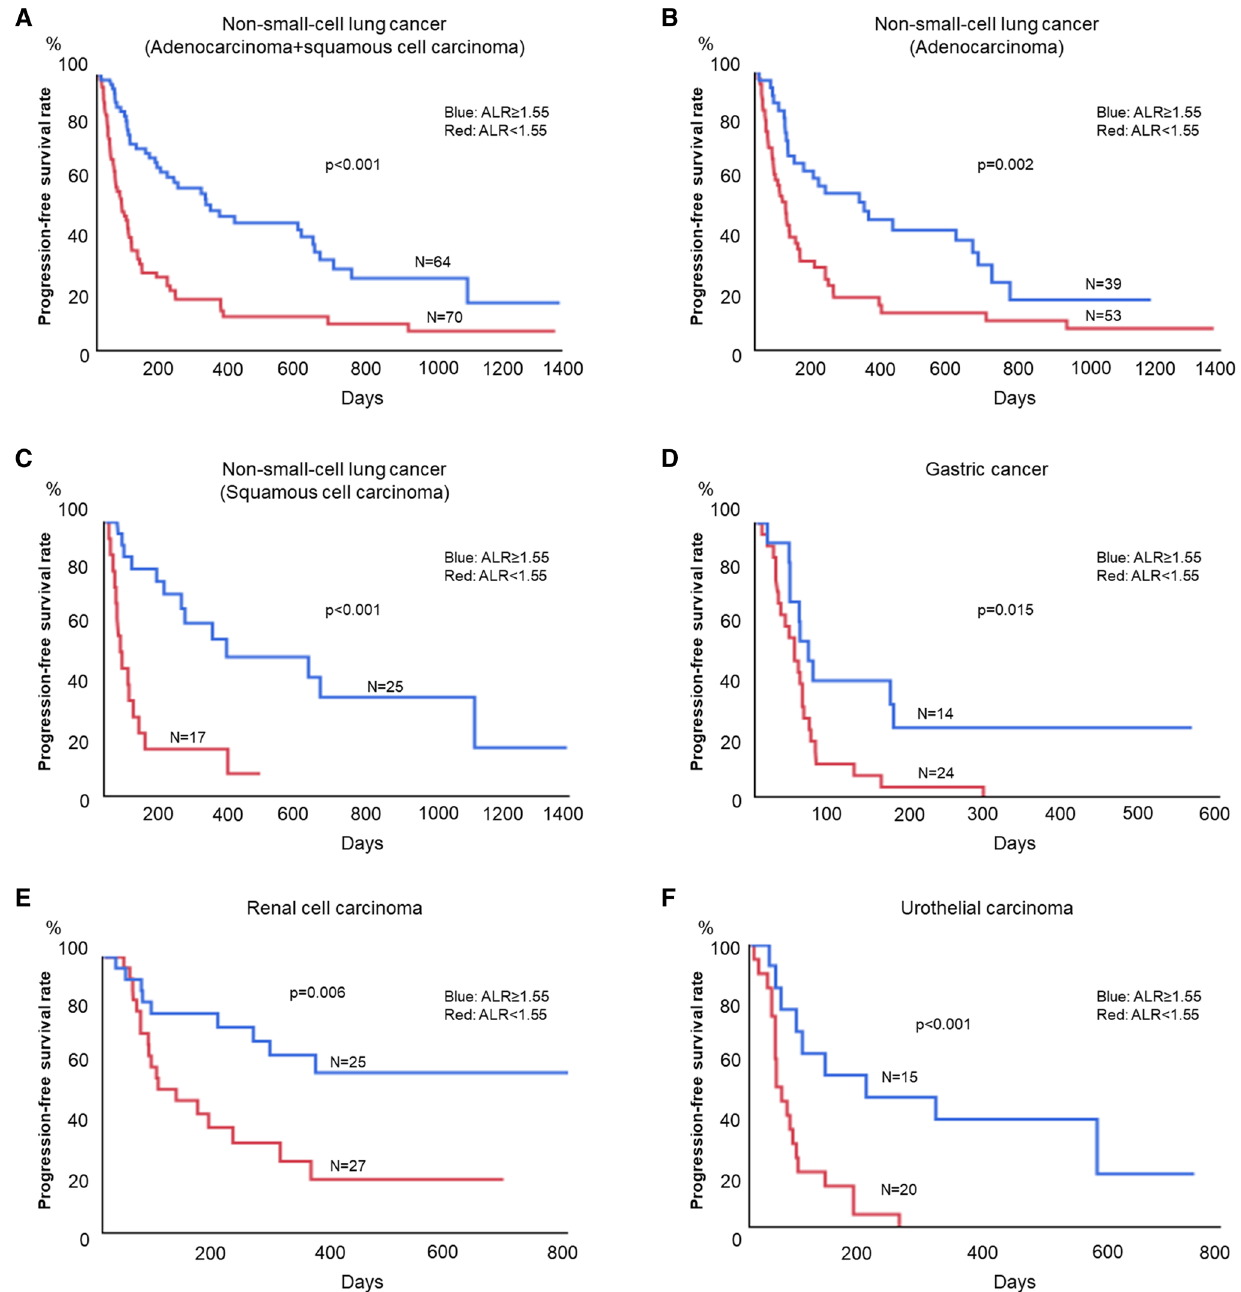
Figure 5. Progression-free survival (PFS) estimated using the ALR for non-small cell lung cancer ( A ), adenocarcinoma of the lung ( B ), squamous cell carcinoma of the lung ( C ), gastric cancer ( D ), renal cell carcinoma ( E ) and urothelial carcinoma ( F